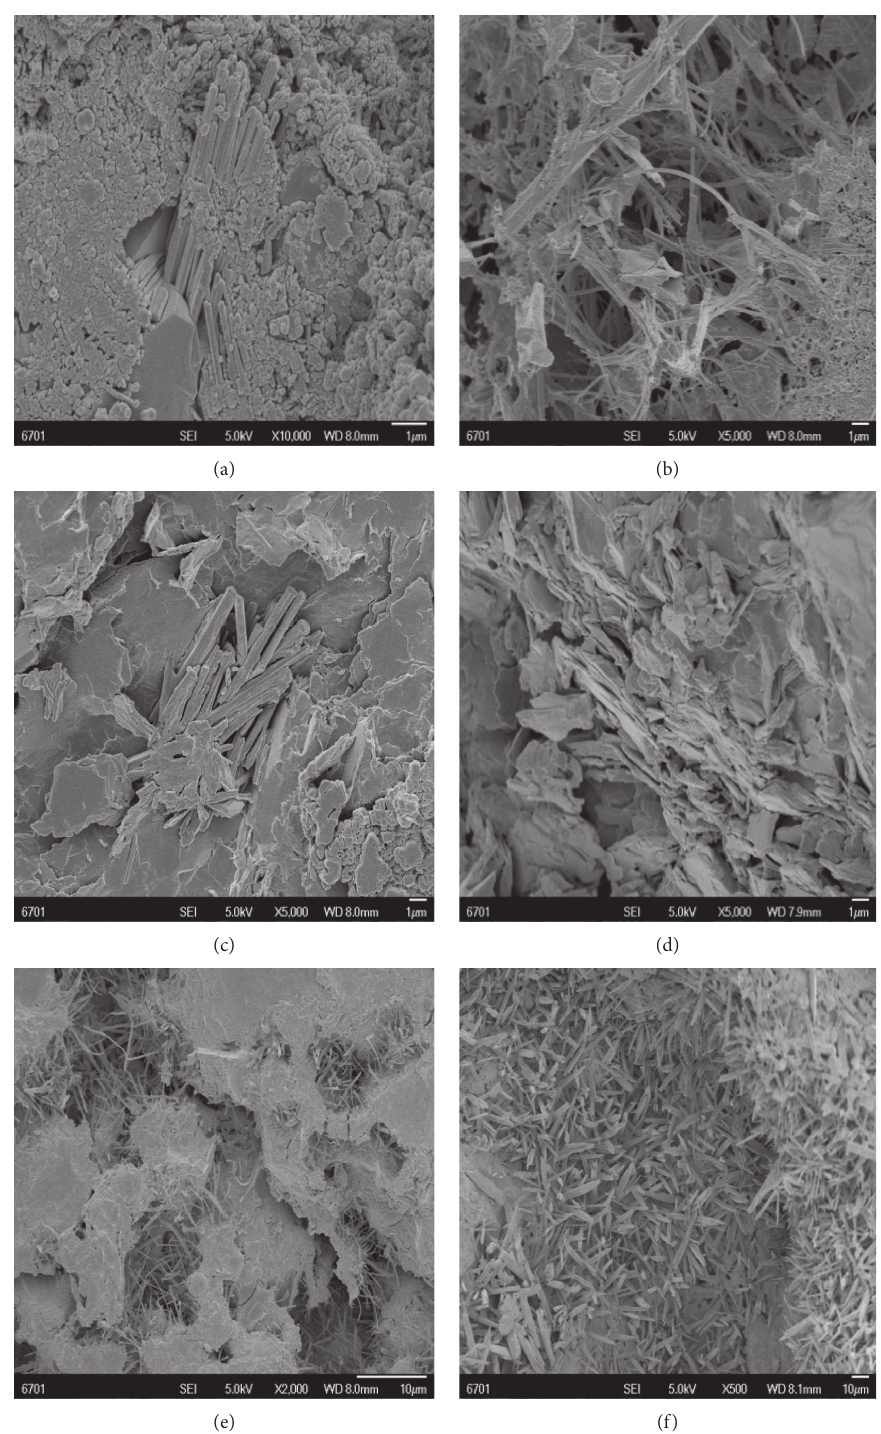
Figure 6: SEM images of degradation of recycled concrete with different proportions. (a) RCA0%–RFA0%. (b)